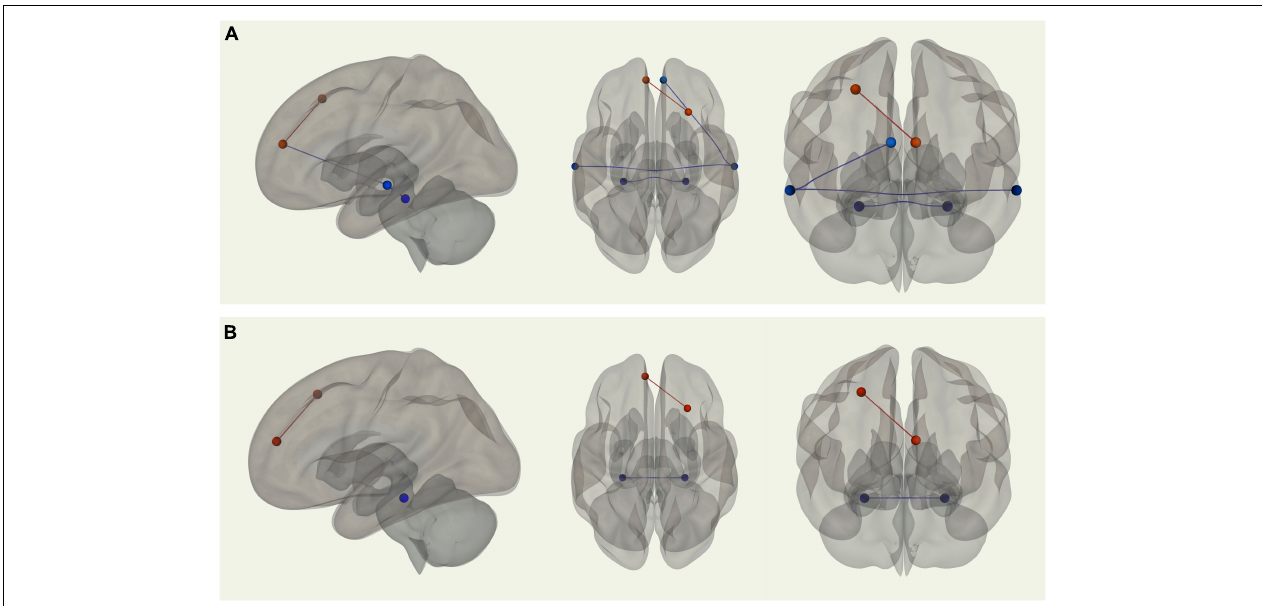
FIGURE 3 | (A) Sagittal, transverse, and coronal images displaying functional connections between ROIs within the DMN that were significantly different in terms of strength between young and older adults and passed correction for false discovery rate; blue connections indicate stronger functional connectivity among young adults, while red connections indicate stronger functional connectivity among older adults. (B) Sagittal, transverse, and coronal images displaying functional connections between ROIs within the DMN that were significantly different in terms of strength between young and older adults when controlling for VO 2 peak and passed correction for false discovery rate; blue connections indicate stronger functional connectivity among young adults, while red connections indicate stronger functional connectivity among older